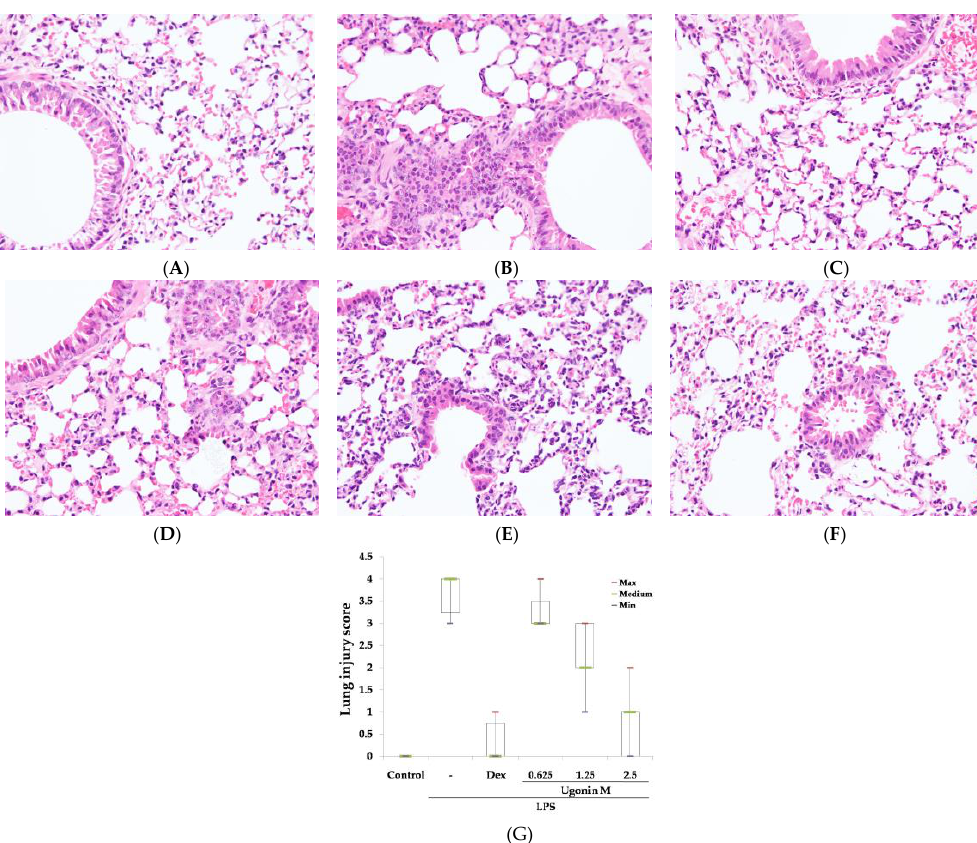
Figure 3. Effect of Ugonin M on lung histological changes in LPS-induced ALI mice: ( A ) Control; ( B ) LPS; ( C ) LPS + 10 mg/kg dexamethasone (Dex); ( D ) LPS + 0.625 mg/kg Ugonin M; ( E ) LPS + 1.25 mg/kg Ugonin M; and ( F ) LPS + 2.5 mg/kg Ugonin M. The infiltrating neutrophils were more